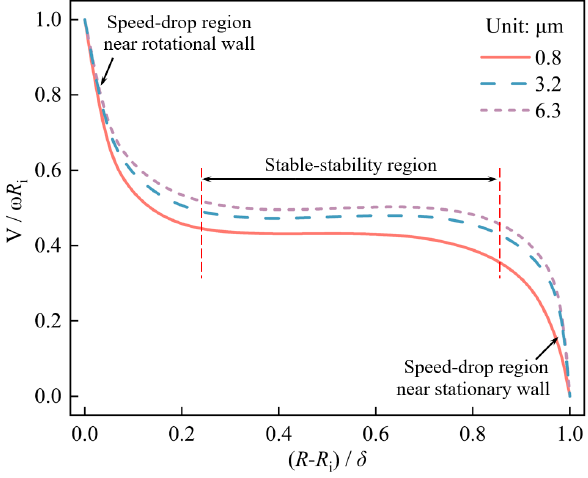
Figure 10. Averaged velocity in the radial direction with Re = 10 4 and Ra = 0.8~6.3 μ m.